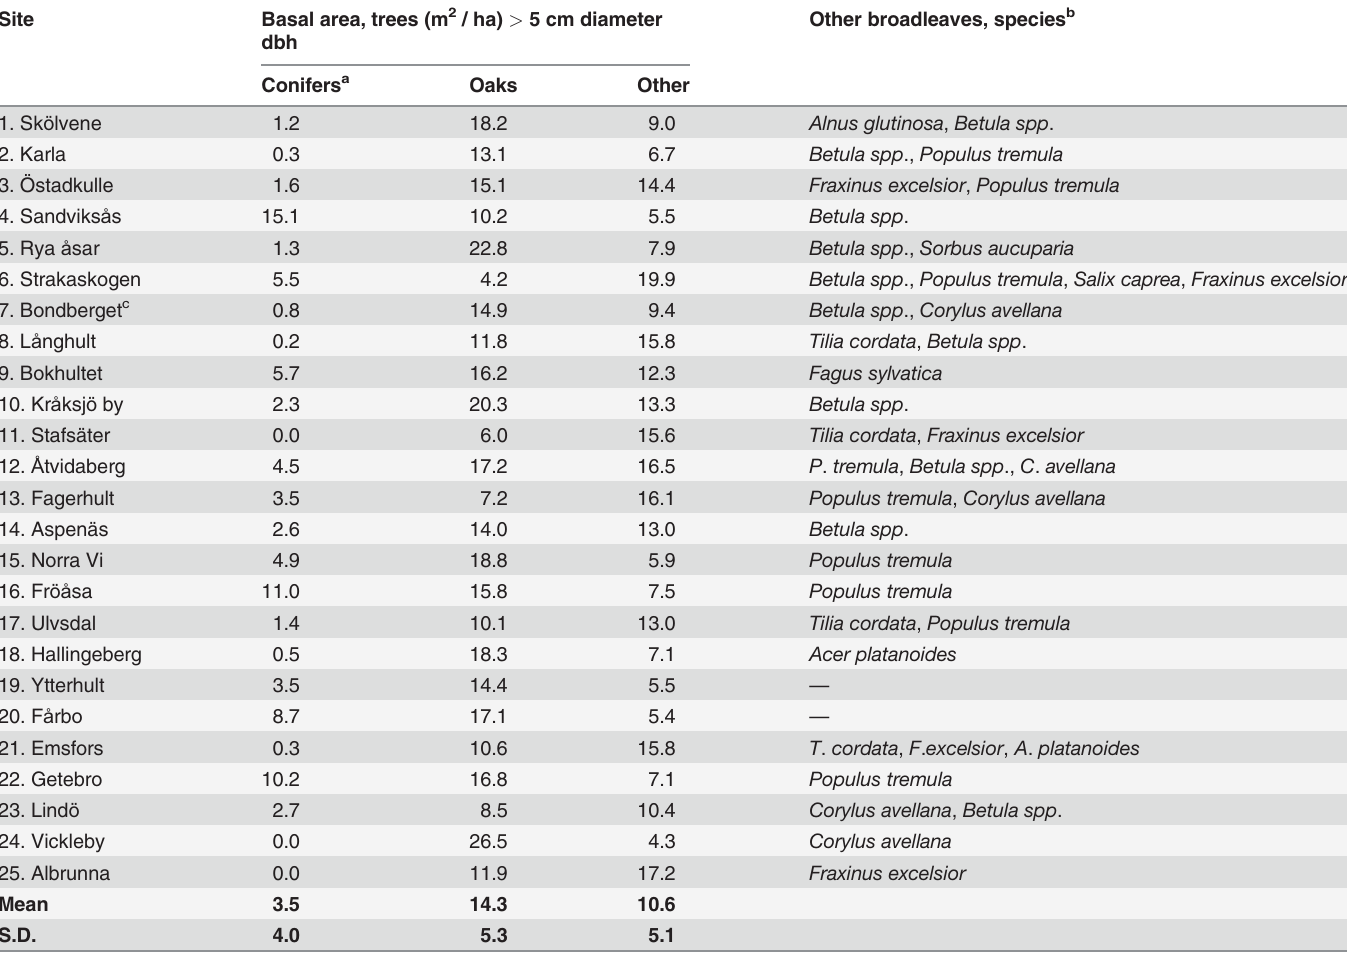
Table 1. Characteristics of the 25 study sites on the map in Fig. 1.